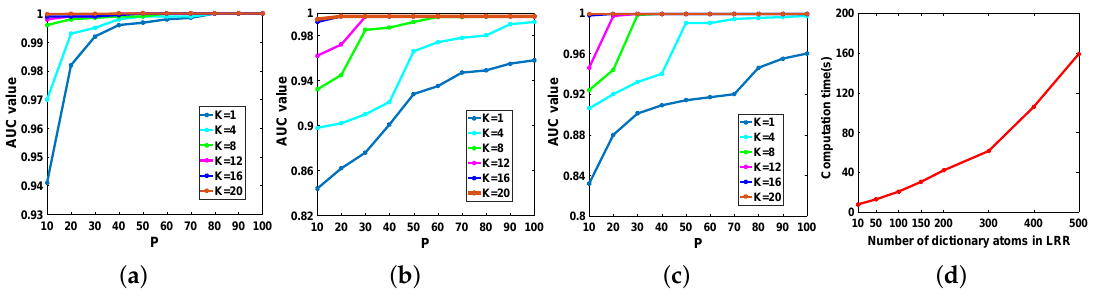
Figure 21. AUC values achieved by DCLaAW with different K and P for each dataset. ( a ) Synthetic dataset; ( b ) San Diego dataset; ( c ) Urban dataset; ( d ) Relationship between calculation time and the number of dictionary atoms used for